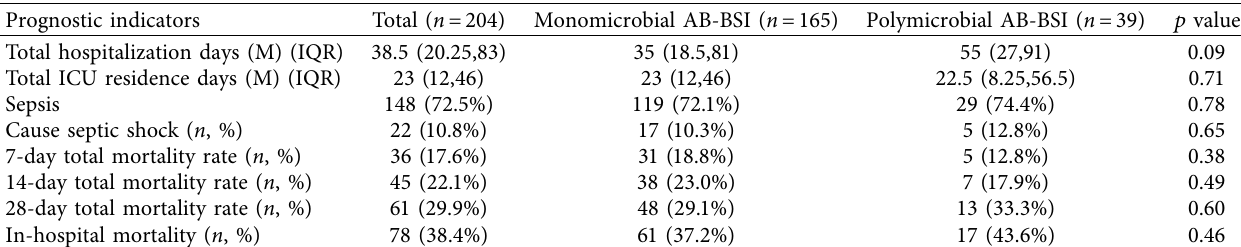
Table 5: Comparison of outcome between monomicrobial and polymicrobial AB-BSI. Prognostic indicators